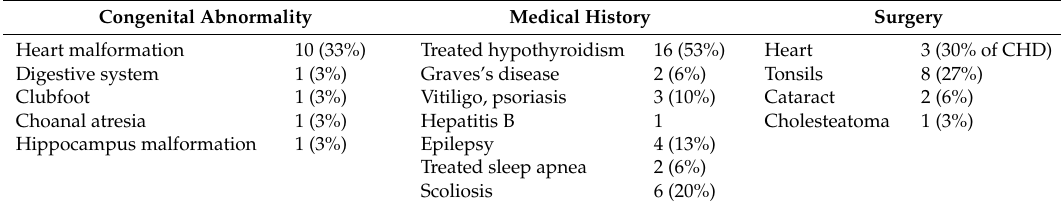
Table 2. Medical History.